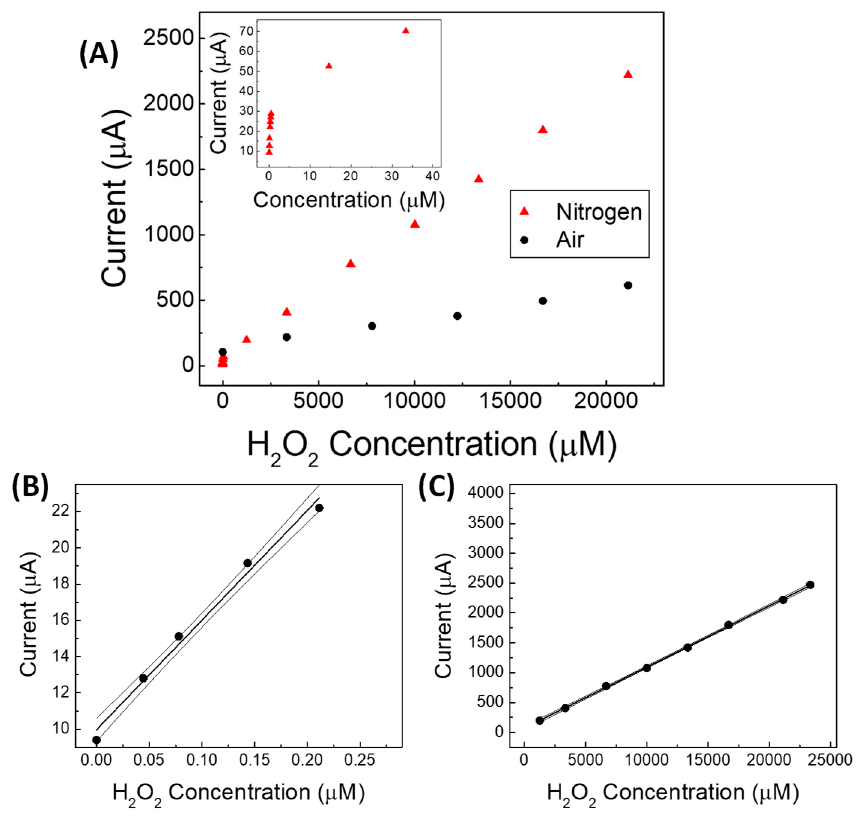
Figure 5. ( A ) Amperometric calibration curves of non-enzymatic (GC-Ag paste )-catalytic proline-assisted LDH sensor under static air and under N 2 stream from 0.05 to 20,000 µ mol L − 1 of hydrogen peroxide; in the inset from about 0.05 to 40 µ mol L − 1 . ( B , C ) straight lines and confidence intervals at low and at high concentration ranges of hydrogen peroxide, respectively, for the proline-assisted LDH sensor operated under N 2 stream. Current straight lines obtained by subsequent additions of 150–200 µL of 3 × 10 − 5 % H 2 O 2 water solution ( B ) and of 3 % H 2 O 2 water solution ( C ).